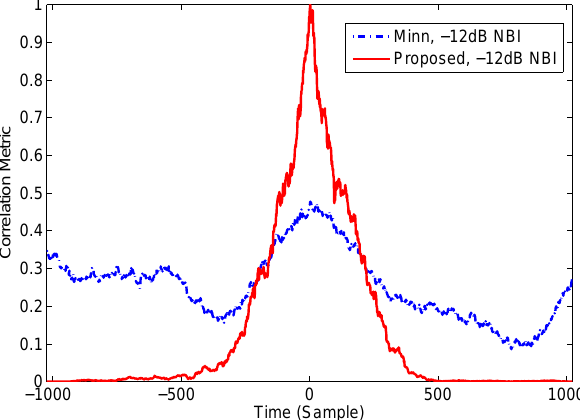
Figure 7. Timing correlation peaks for two methods in the presence of